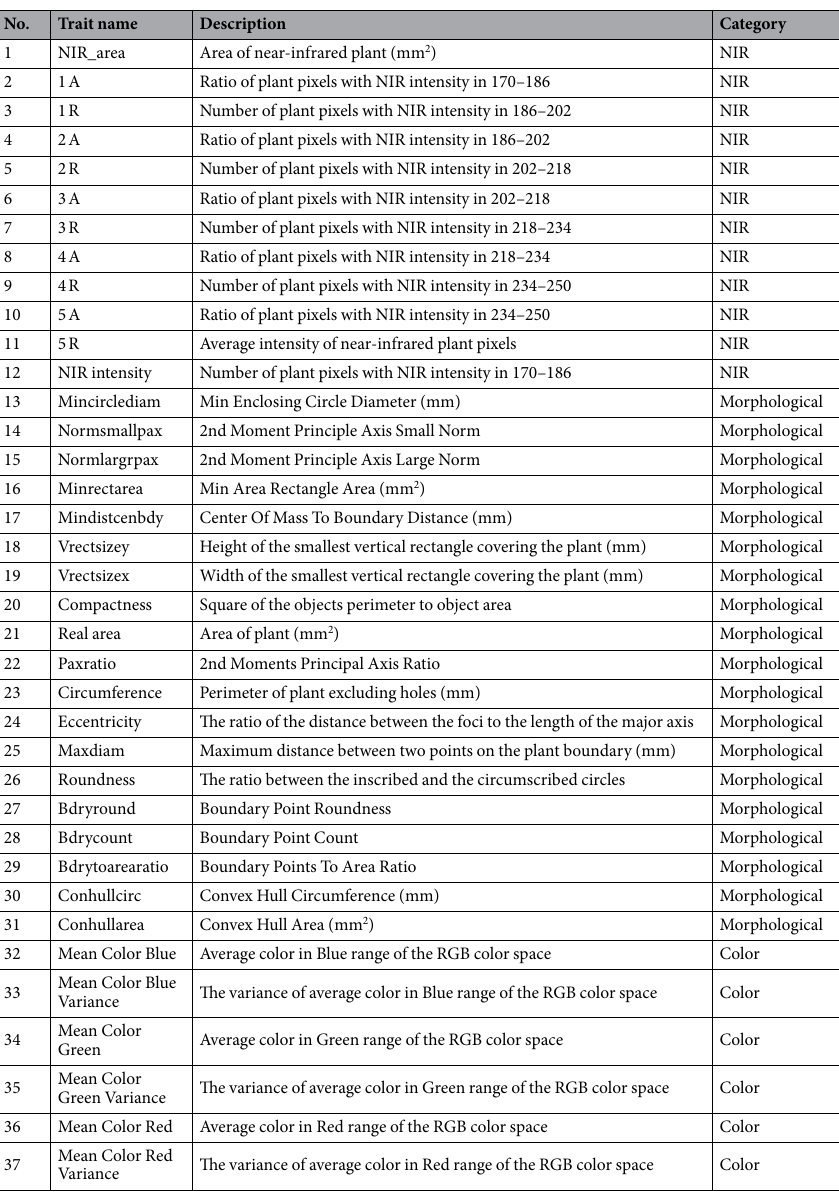
Table 1. Phenotypic traits extracted from images for each